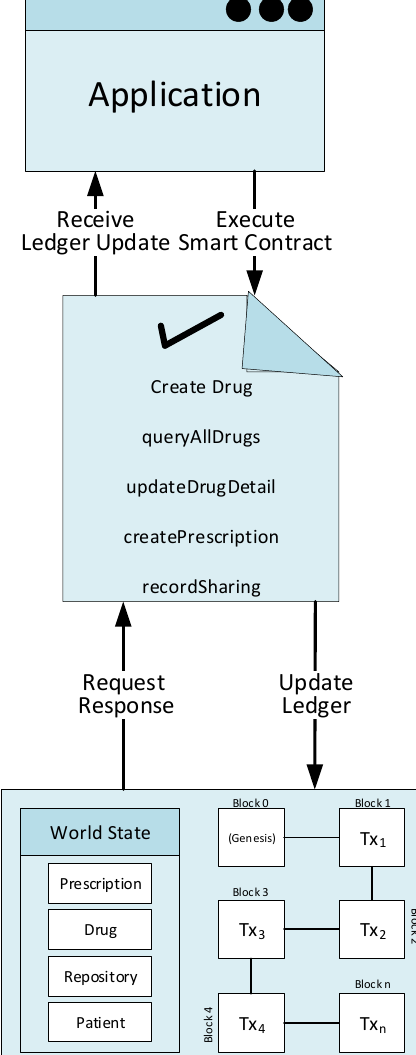
Figure 6. Querying and updating a ledger using a smart